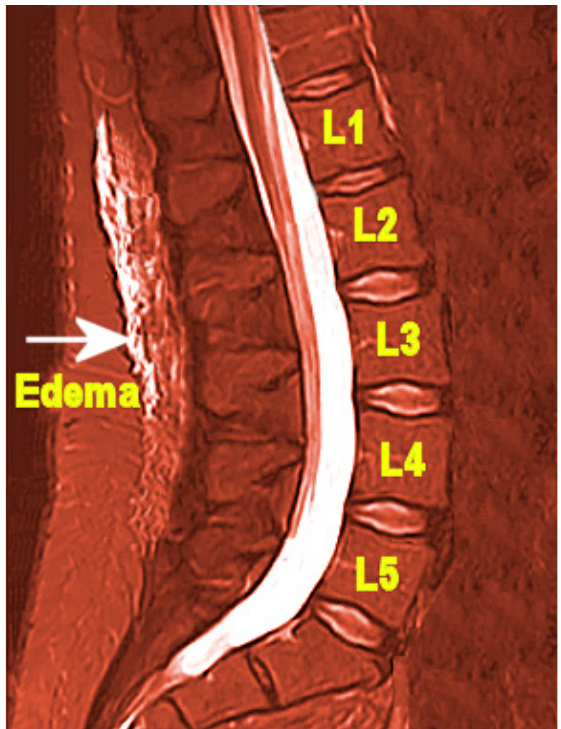
Figure 1. Posterior lumbar subcutaneous edema. Adapted with permission from Schwarz-Nemec et al., 2020 [12].